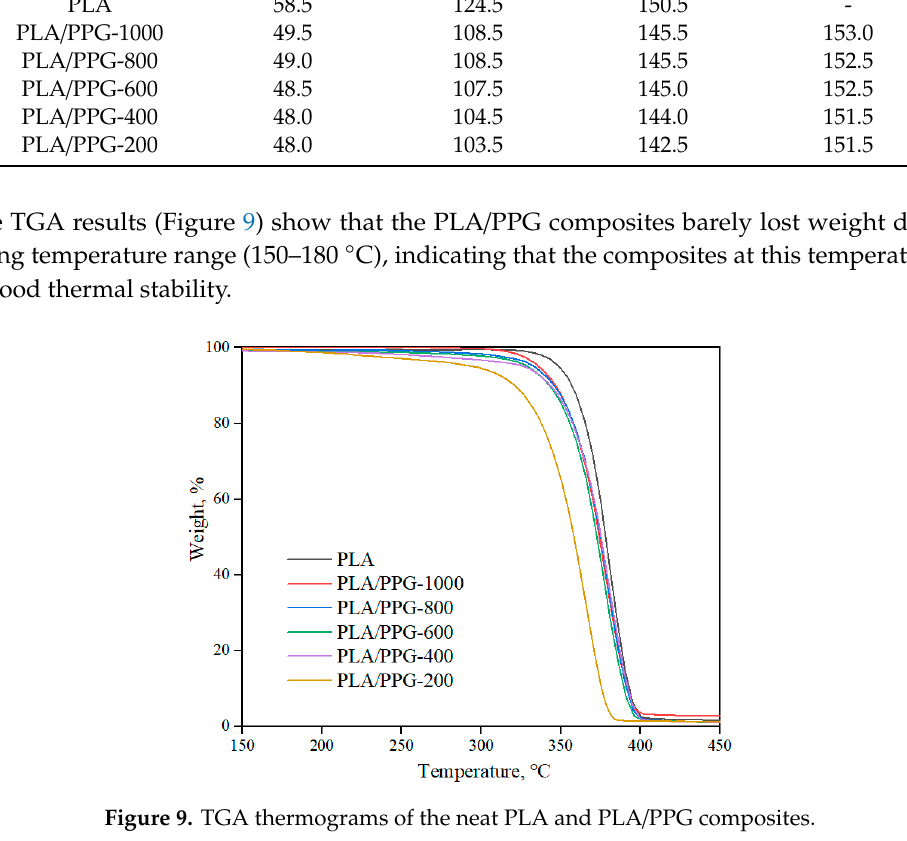
Figure 8. Differential scanning calorimetry (DSC) thermograms of the neat PLA and PLA / PPG composites. Table 3. DSC data for the neat PLA and PLA / PPG composites.